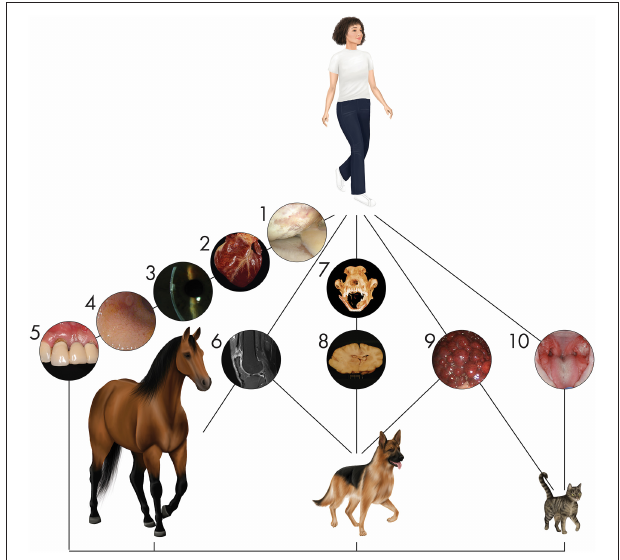
FIGURE 1 | Naturally occurring diseases are shared between companion animal and human patients. Representative diseases in different organ systems affecting multiple species are depicted. (1) Arthroscopic image of a human knee joint affected by severe osteoarthritis. Osteoarthritis is one of the most common orthopedic conditions affecting humans and companion animals. (2) Heart of a dog affected by myocardial disease. Specific cardiac disorders, well known in humans, are also seen in veterinary patients. (3) Corneal endothelial dystrophy in the eye of a person is similar to that seen in dogs. (4) Gastroduodenal endoscopy in a cat reveals inflammatory bowel disease. Its appearance and pathogenesis have extensive similarities with the human condition. (5) Periodontal disease in a person is similar to the disease seen in dogs and cats with prevalence positively associated with increasing age. (6) Tendon injury is a common sport injury, whether the athlete/patient is human (seen here), horse, or dog. (7) Mandibular reconstruction to repair critical-size bone defects using regenerative approaches in dogs are informing similar approaches in humans ( 12–14). (8) Inflammatory brain disease in dogs serves as a model for this human condition in clinical trials using stem cells. (9) A cirrhotic liver arising from chronic hepatitis in a dog shares parallels with the human condition. (10) Stem cell therapy for the treatment of chronic gingivostomatitis in cats, a chronic oral mucosal inflammatory disorder, provides hope for successful treatment of similar human disorders such as lichen planus through immunomodulation ( 8, 15,